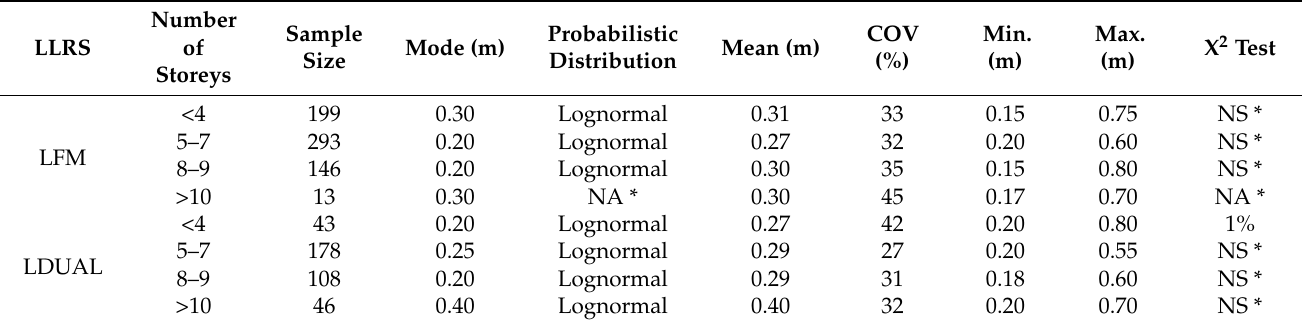
Table 8. Probabilistic distribution of RC columns (cid:48) width in function of the lateral load resisting system (LLRS) and number of storeys.